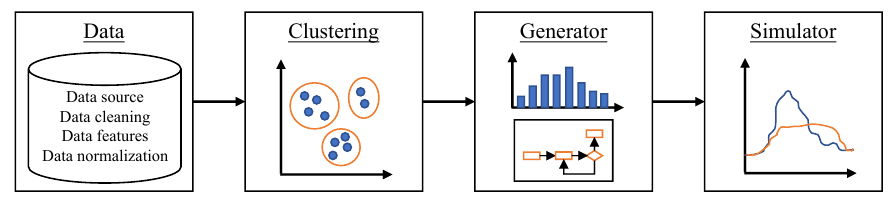
Figure 1. Scheme of the methodology of the